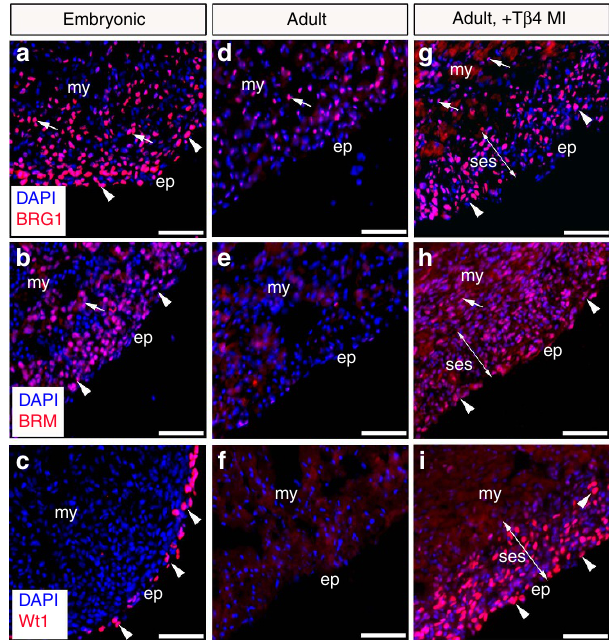
Figure 1 | BRG1 and BRM are expressed in the developing and adult epicardium. ( a – i ) Immunostaining for BRG1, BRM and Wt1 in mouse E11.5 ( a – c ), adult ( d – f ) and adult primed- ( þ T b 4), -injured (day 4 post-MI) hearts ( g – i ). Arrows mark myocardium, arrowheads mark epicardium and double-arrow indicates the expansion of the subepicardial space post-MI. ep, epicardium; my, myocardium; ses, subepicardial space. All scale bars 100 m m. NATURE COMMUNICATIONS|8:16034|DOI: